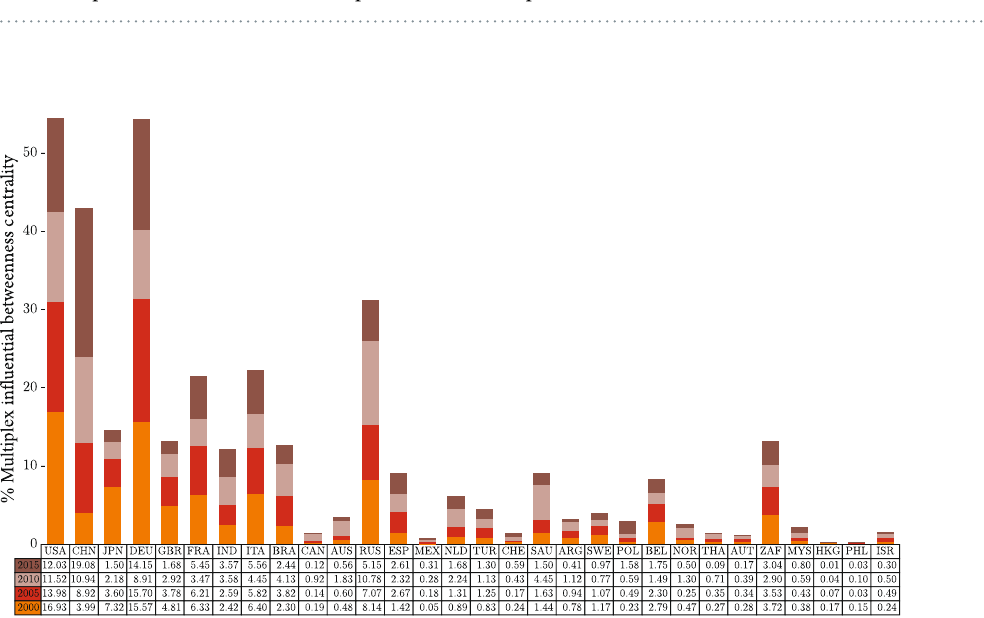
Figure 1. Characteristics of influential Pareto paths. ( a ) Representation of the network interdependence parameter for influential Pareto paths in five datasets. ( b ) Representation of the average number of inter-layer switches. ( c ) The fraction of participation of each layer in the influential Pareto paths. ( d ) Representation of the domination percentage of influential Pareto paths by the paths with minimum number of links traversed in each layer, for each pair of nodes for four datasets; and the total domination percentage of influential Pareto paths. The white points show that there are no paths between two pairs of nodes.